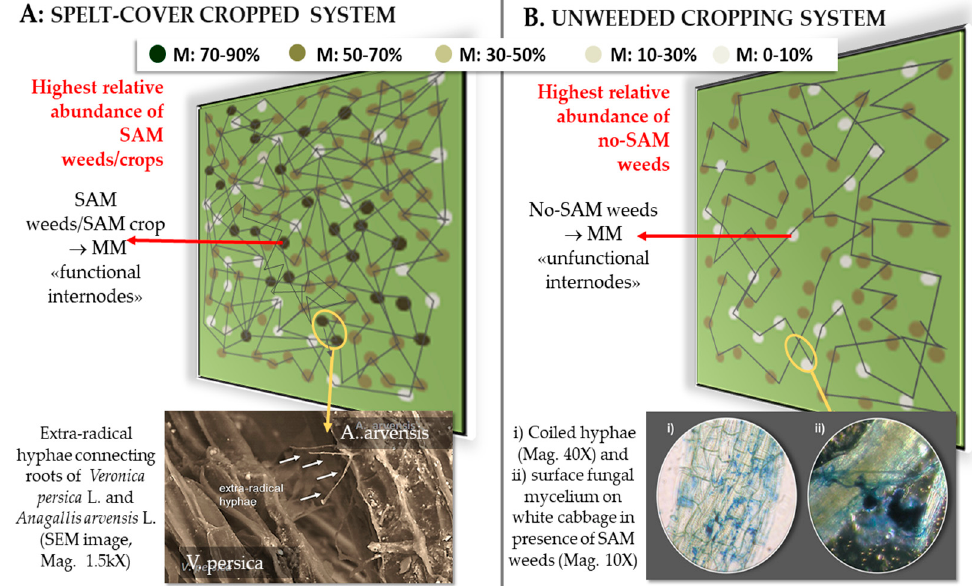
Figure 5. Comparison between common extra-radical mycorrhizal mycelium (MM) in two horticultural cropping systems differently managed (CREA-OF, Monsampolo del Tronto, AP, Italy): A. Weed control using spelt ( Triticum dicoccum L.) as cover crop: electron scanning microscopy shows connecting hyphae between Veronica persica and Anagallis arvensis , both SAM weeds. B: non-weeded system, without cover crop (control): optical microscope images show coiled hyphae and surface, non-colonizing fungal mycelium on no-SAM Amaranthus retroflexus . Area = 1.0 m 2 . Total dots in each area correspond to the total number of plants×m − 2 ( ∑ main crop + weeds/m 2 ) counted in the field. Each dot represents a single individual plant (cover crop + weeds in A, weeds in B). Increasing color darkness corresponds to an increasing range of mycorrhizal colonization intensity of each plant species (M% ranges, as reported). Year: 2015. (Modified from: [58]).